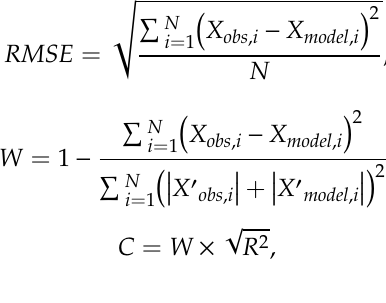
Figure 10. Test layout of test platform for full bridge flexible detection structure acquisition system.